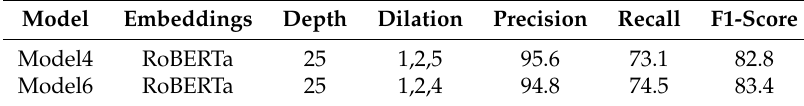
Table 4. Comparison of different